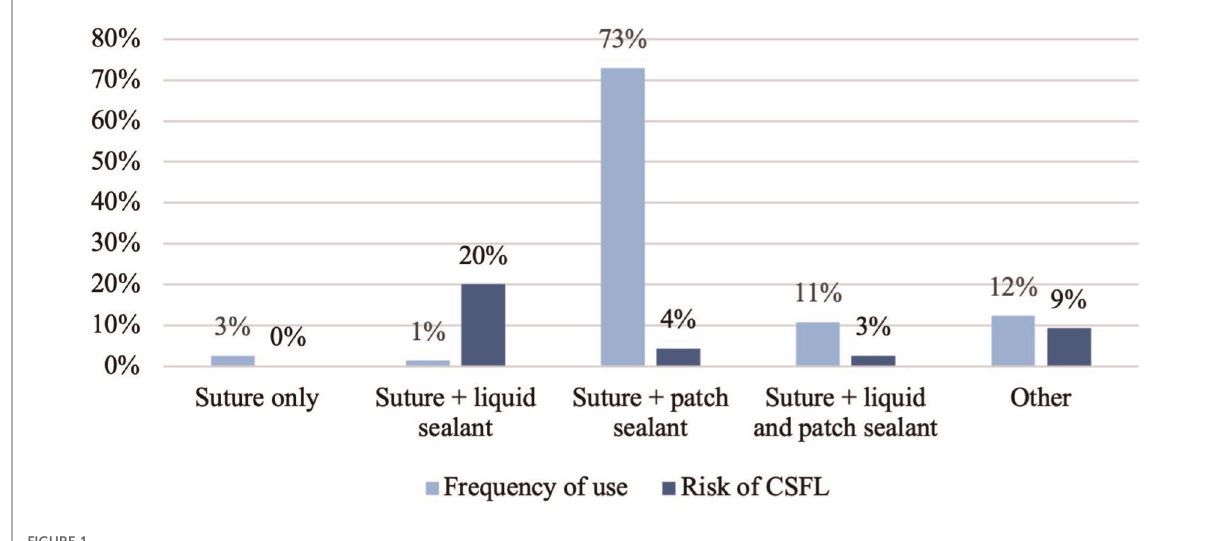
FIGURE 1 Dural closure technique and risk of cerebrospinal fl uid leak development.